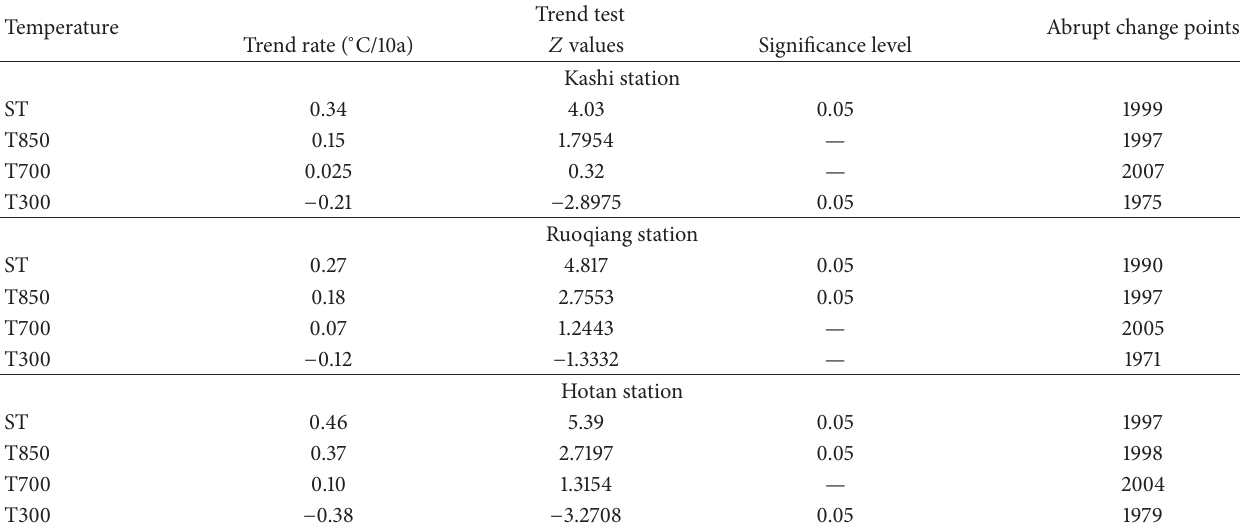
Table 2: The test results of change trends and abrupt changes of the three